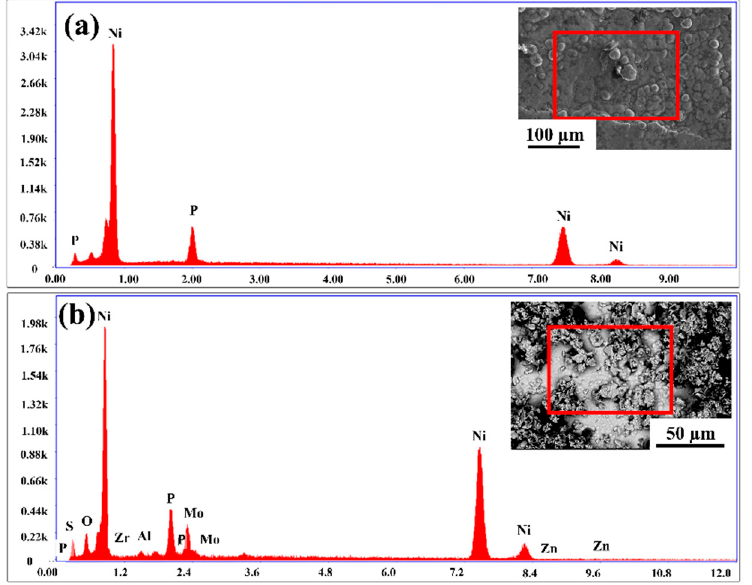
Figure 7. The elemental concentrations (EDS) of ( a ) the Ni-P coating and ( b ) composite coating with 2 g/L Al 2 O 3 and 2 g/L MoS 2 powder